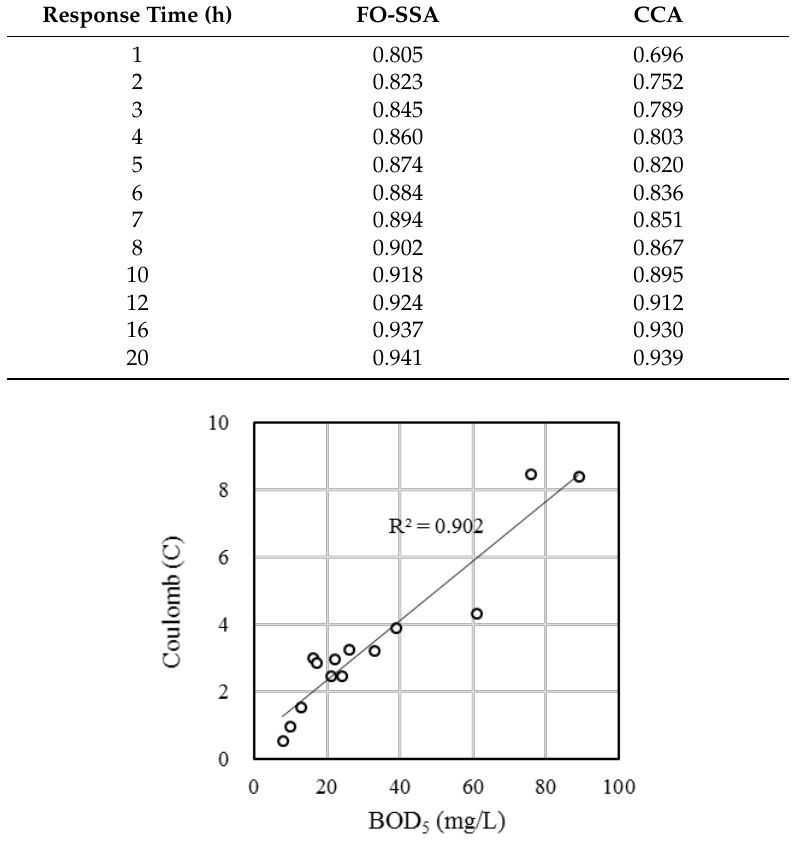
Table 1. R 2 values of the correlation between coulomb and BOD 5 at the indicated response times for biosensors equipped with an FO-SSA or a CCA ( n = 14).